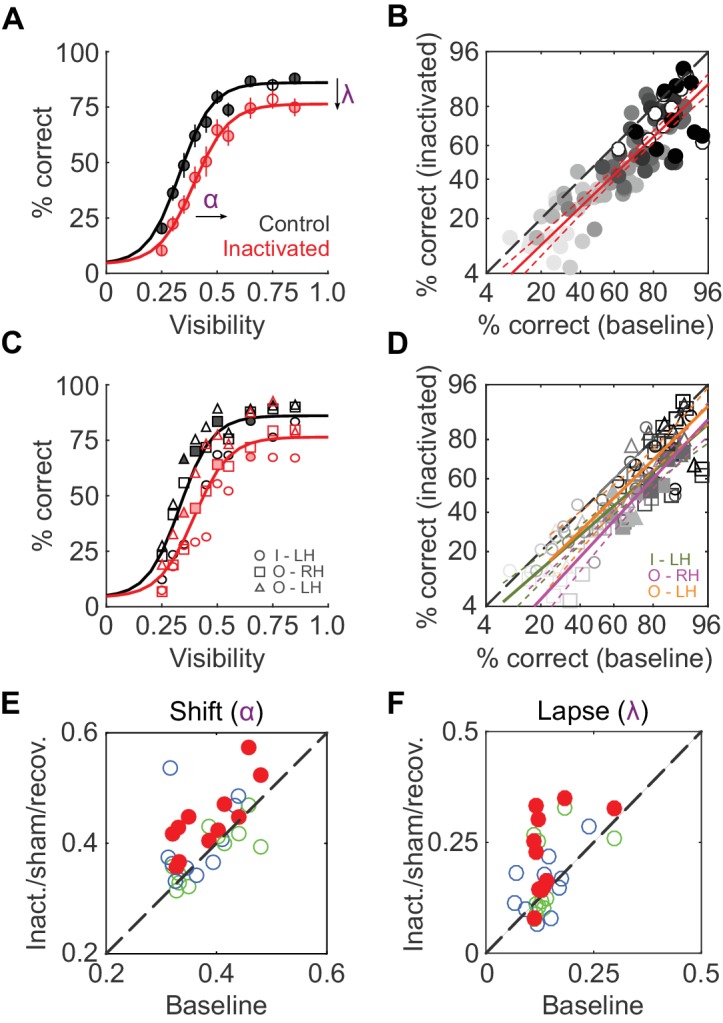
ML inactivation causes face-detection deficits.(A) Face-detection performance as a function of stimulus visibility under baseline (black) and ML-inactivated (red) conditions. Circles correspond to average performance, error bars to ±1 s.e.m. Lines are psychometric function fits to all performance data. Filled circles: p<0.05, FDR-corrected paired t-tests after logit transform. (B) Performance in the inactivated condition plotted as a function of performance in the corresponding baseline condition, sorted by stimulus visibility (grayscale luminance). Filled circles are the significant points from (A). These data were well-fit by a line (red; R2 = 0.74; p<0.001) with a slope close to 1, and a significantly shifted intercept (p<0.001) compared withthe diagonal. Dashed red lines represent the 95% confidence intervals. (C and D) The data in (A) and (B), but separated into individual inactivated hemispheres. Filled symbols denote statistically significant differences between the control and inactivated conditions (p<0.05, FDR-corrected paired t-test after logit transform). Symbols are as in Figure 1. (E and F) Face-detection performance as quantified by shift α (E) and lapse λ (F) during three conditions (ML-inactivated (red), recovery (green) and off-target (blue)) versus baseline condition. Shift and lapse were derived from psychometric function fits to face-detection data, and were significantly altered from baseline during inactivation (filled red circles; p<0.001 for shift and p<0.05 for lapse; paired t-test). Note that the axes in (B) and (D) are logit scaled.